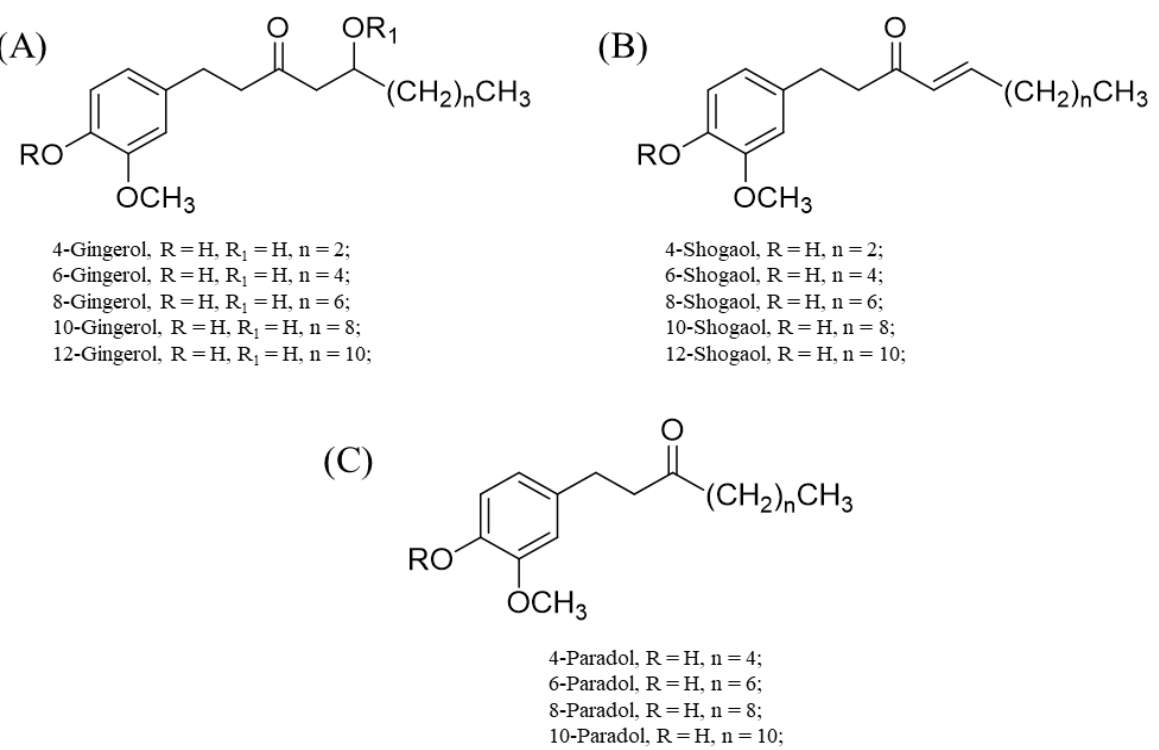
Figure 2. Chemical structures of 4-, 6-, 8-, 10- and 12-gingerols; 4-, 6-, 8-, 10- and 12-shogaols; and 4-, 6-, 8-, and 10-paradols. ( A ) Basic skeletal structure of the gingerols and specific substituents that correlate to each gingerol type. ( B ) Basic skeletal structure of the shogaols with respective substituents for specific shogaol types. ( C ) Basic skeletal structure of the paradols with specific substituents for each paradol type.